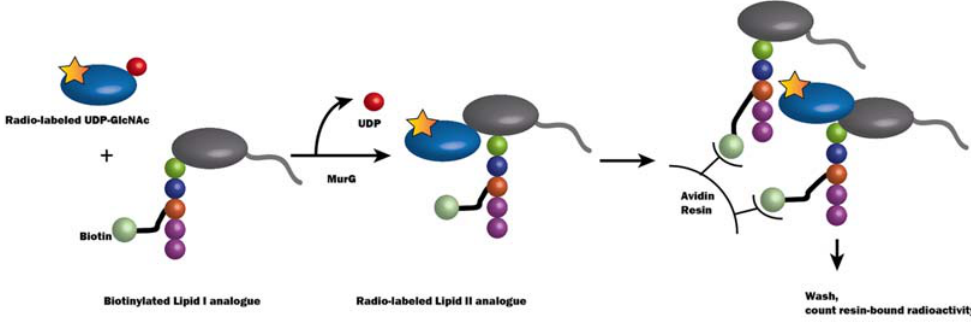
Figure 7. Schematic illustration of the biotin-capture assay for MurG activity [91]. In this assay, MurG catalyzes a reaction between radiolabeled (depicted by a yellow star) UDP-GlcNAc and biotinylated Lipid I analogue, and Lipid II with the radiolabel is synthesized. The avidin resin, which binds to biotin, therefore catches the radioactivity, which can be counted to indicate the MurG activity.